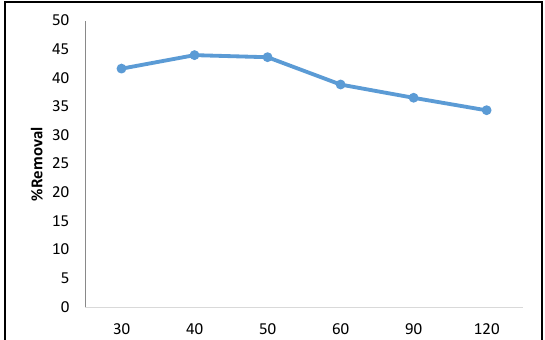
Fig. 4. The removal efficiency of Cr (VI) by ferrous sulfate at different contact times (30, 60, 90, and 120 min)